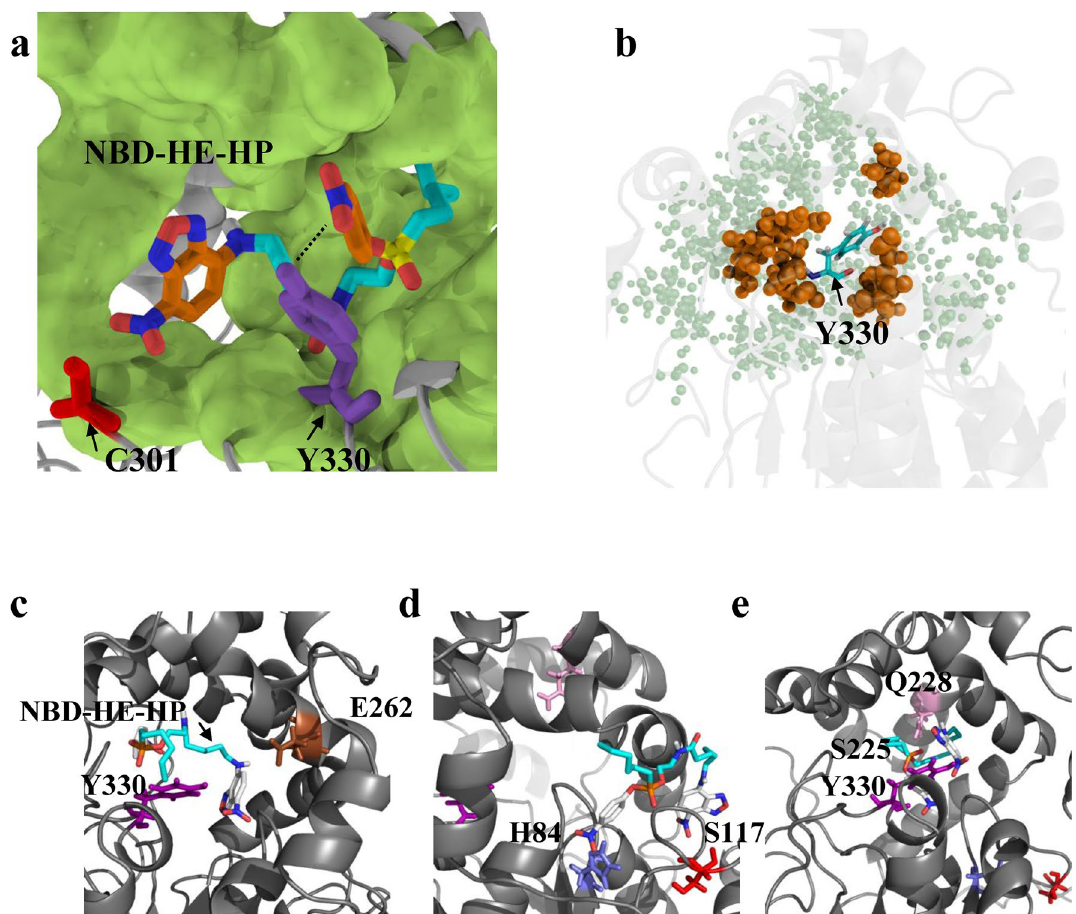
Figure 7. Affinity probe of identifying ABHD5 binding sites. The docking pose underpinned by LC–MS/MS analysis demonstrated the affinity probe forms an adduct with Y330. ( a ) The binding pose of NBD-HE-HP (sticks) was predicted in the binding pocket α (R 299 G 328 D 334 ). The nitrophenol moiety of NBD-HE-HP was docked spatially close to the hydroxyl group of Y330 (purple) and the NBD moiety was placed near the neighborhood of C301 and Y330 of H 329 YVYAD 334 motif (orange spheres) in a close-up view in ( b ), whereas the acyl-tail (cyan sticks) penetrated the tunnel that connects the binding pockets (α and θ). ( c ) The NBD moiety of NBD-HE-HP has a higher affinity of binding to Y330 and E262, S117 and H84 as shown in ( d ), S225 and Q228 in ( e ). Our experimental tests showed that mutations on these identified residues lead to disrupting NBD-HE-